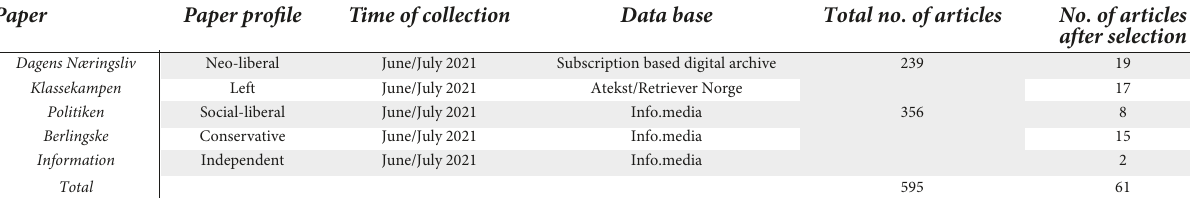
TABLE 1 Characteristics of the data sources and data